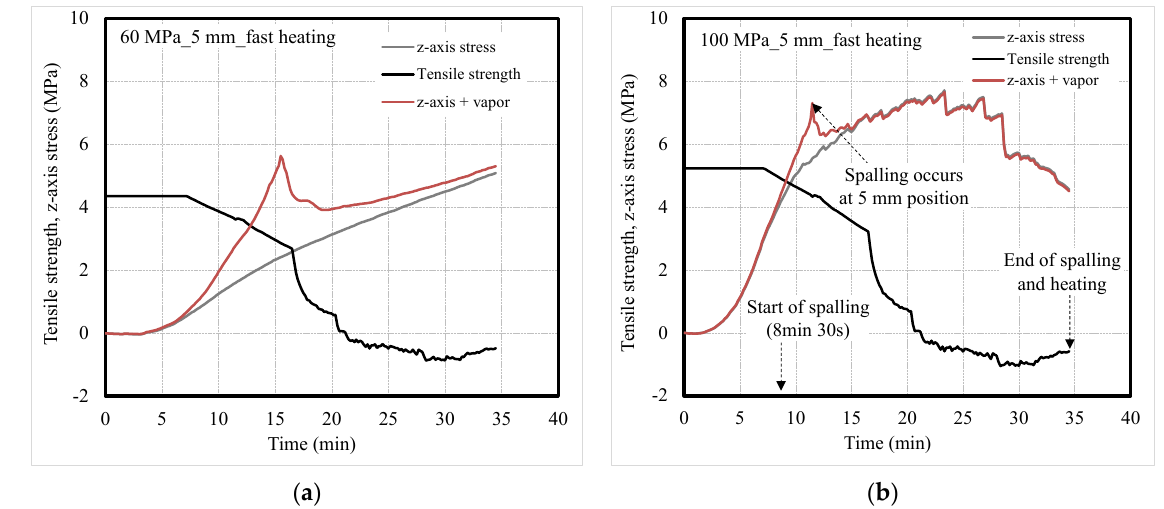
Figure 11. Tensile strength and z -axis stress of concrete under fast heating; ( a ) 60-MPa and ( b ) 100-MPa specimens.